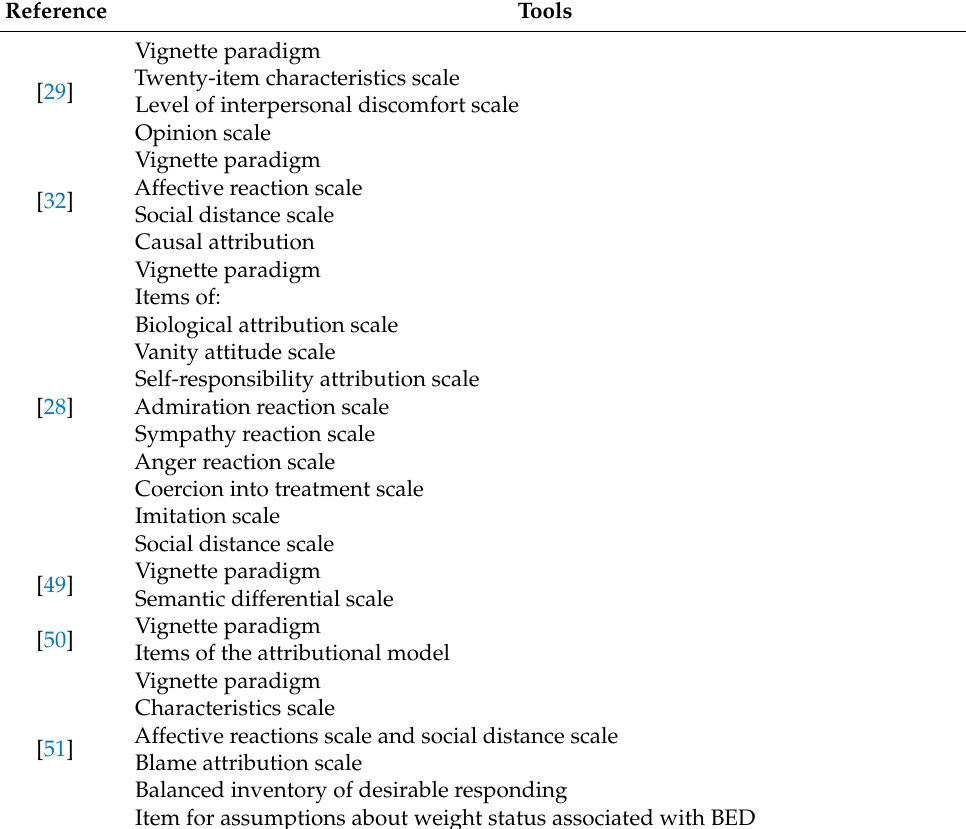
Table A1. Details of the tools used in the included